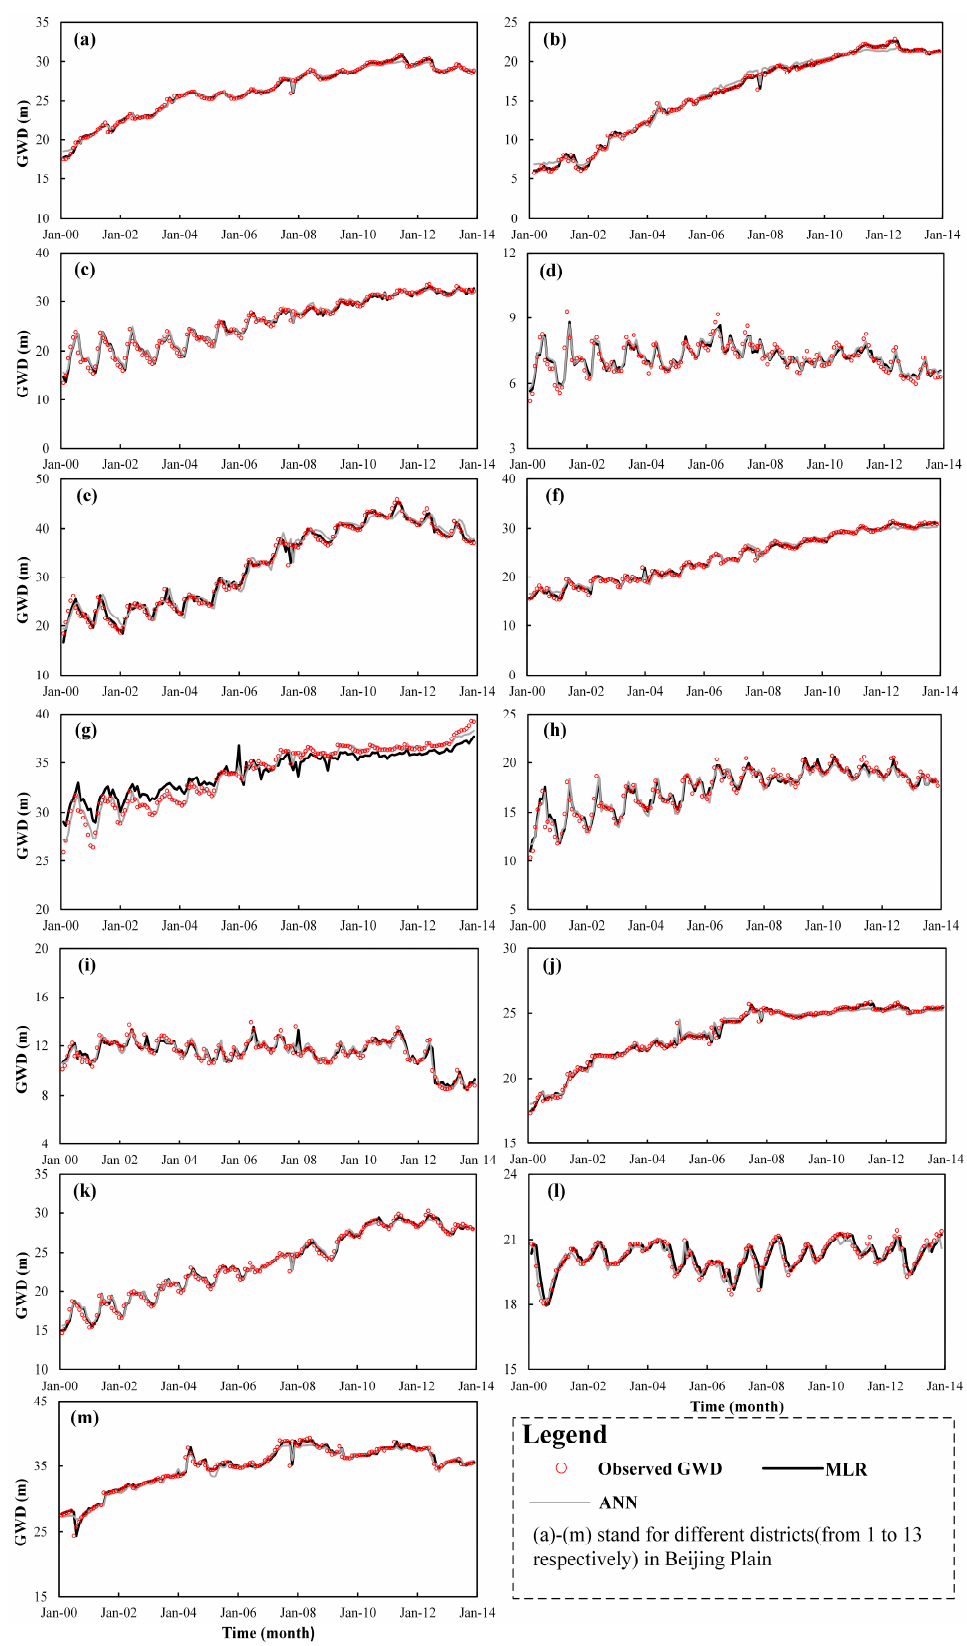
Figure 7. Comparison of observed and predicted groundwater depth (GWD) by multiple linear regression (MLR) and ANN